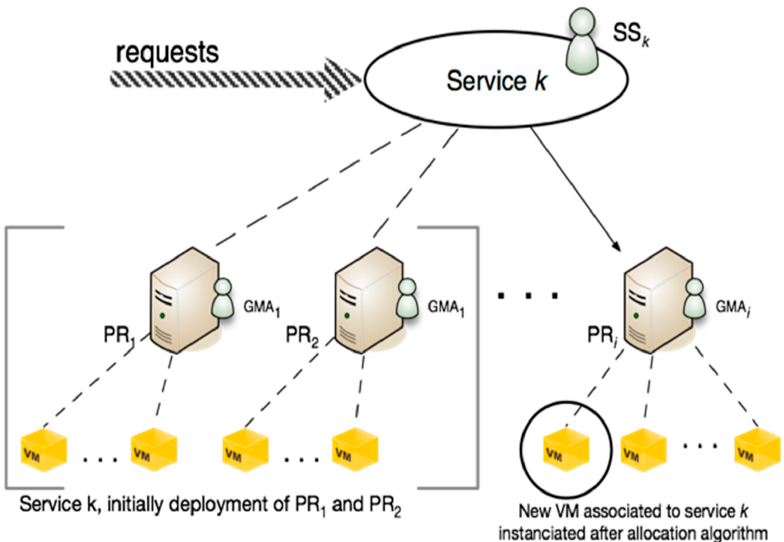
virtual machine